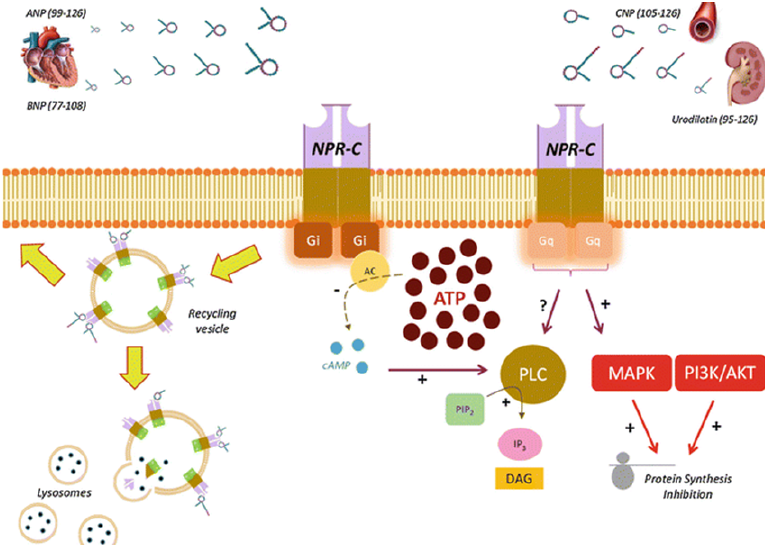
Figure 1. NPR-C signaling pathway. AC: adenylyl cyclase; ANP: Atrial Natriuretic Peptide; AKT: protein kinase B; ATP: adenosine triphosphate; BNP: Brain Natriuretic Peptide; cAMP: cyclic adenosine monophospate; CNP: C-type Natriuretic Peptide; DAG: diacylglycerol; Gi: G inhibitory protein; Gq: Gq protein; IP3: inositol triphosphate; MAPK: mitogen-activated protein kinase; PI3K: phosphatidylinositol 3 kinase; PIP2: phosphatidylinositol 4,5-bisphosphate; PLC: phospholipase C. + : stimulation;